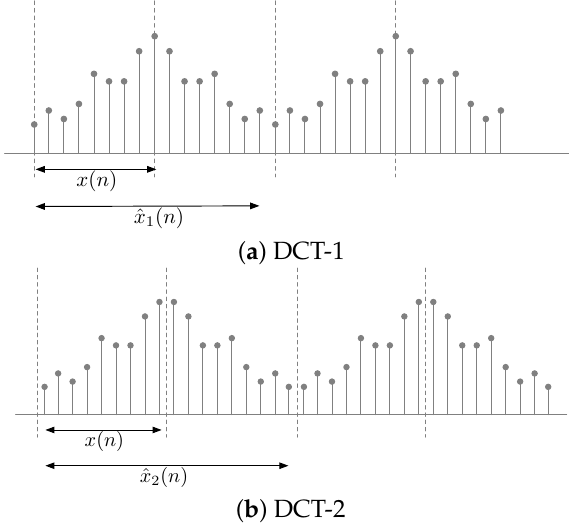
Figure 1. Original sequence and symmetrically extended